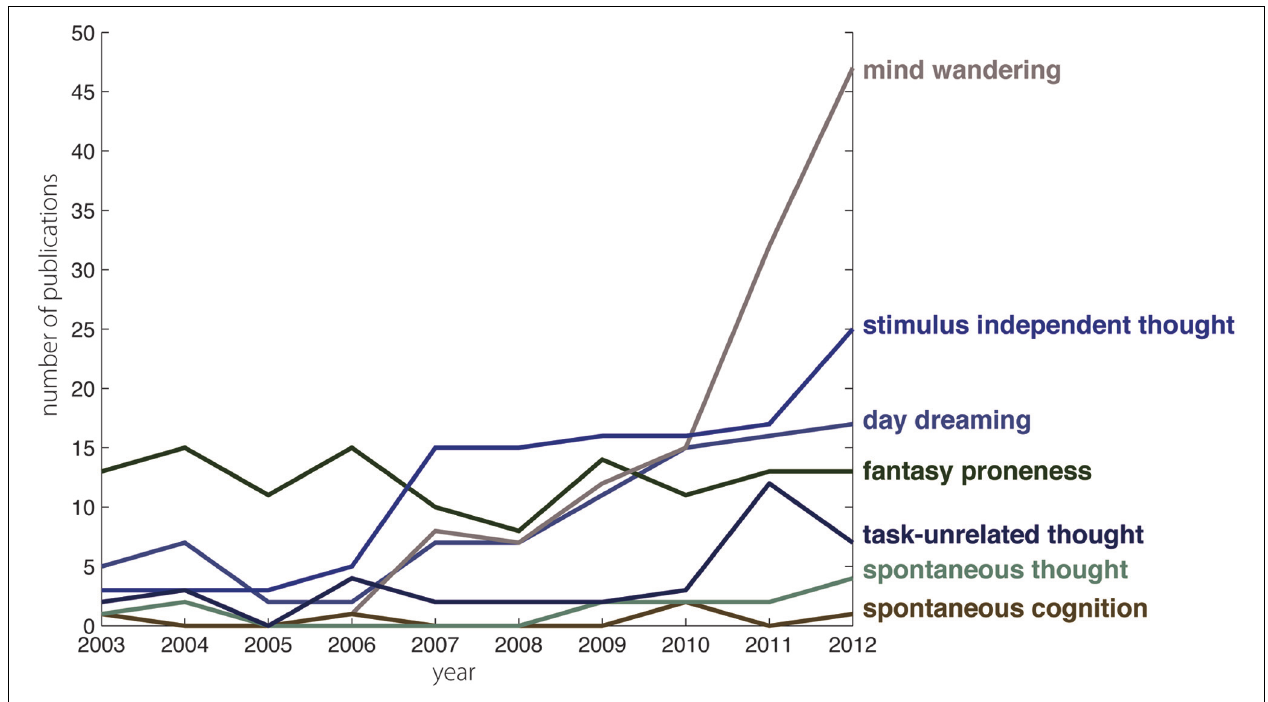
FIGURE 1 | Changes in the frequency of citations across the ten years prior to 2013. It is apparent that the term mind wandering has seen a rapid increase in the frequency of papers using this term over this period. By contrast, some research that uses other, related terms has remained at a relatively consistent level over the same period.